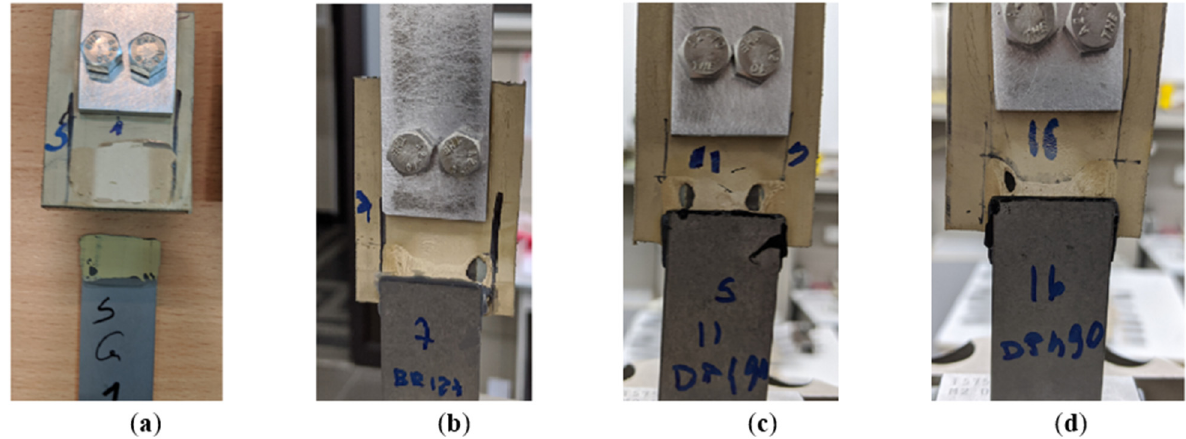
Figure 14. Characteristics of fractures during the shear strength test: ( a ) Bonding 2216B/A + BR-127 primer after aging; ( b ) Bonding 2216B/A + BR-127 primer without aging; ( c ) Bonding DP490 after aging, ( d ) bonding DP490 without aging.